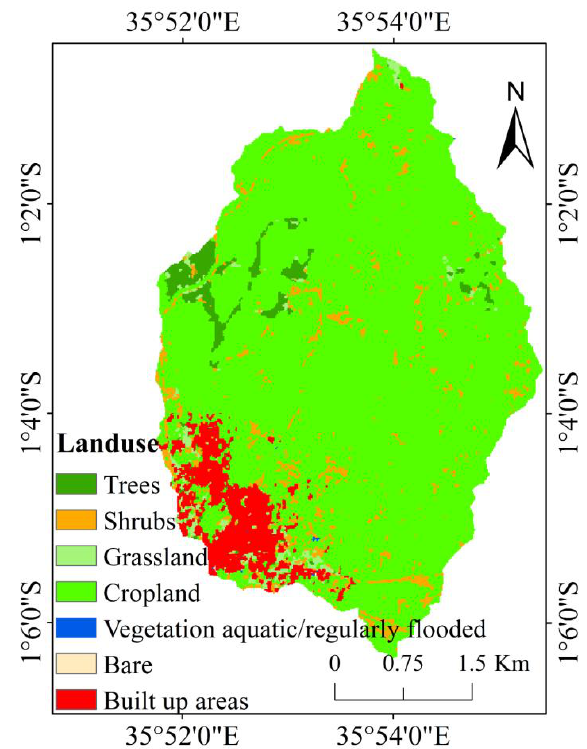
Figure 6. Gully erosion conditioning factors: land